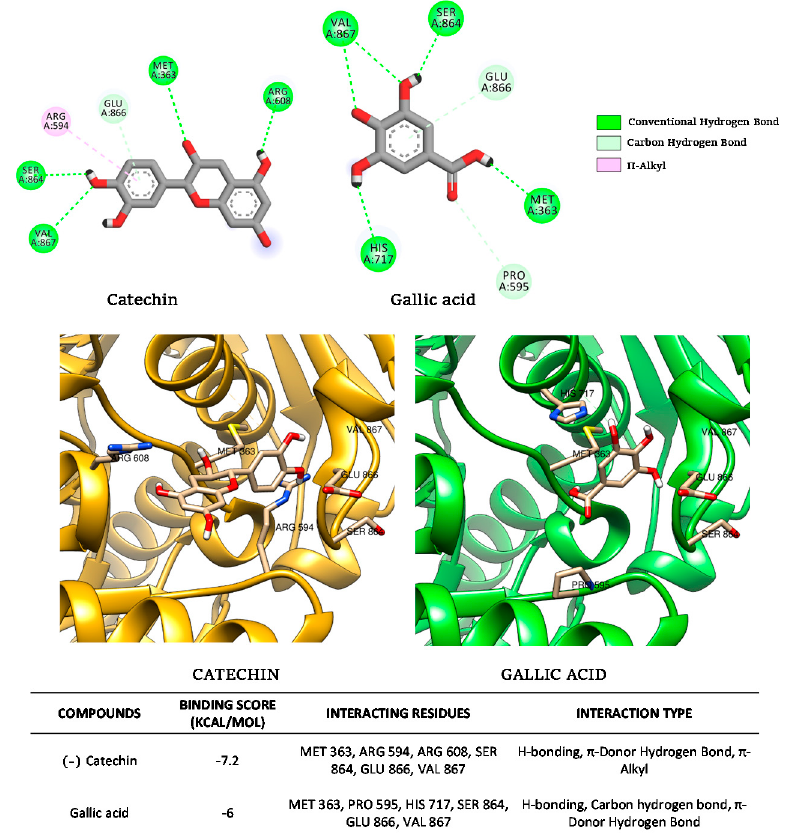
Figure 8. Molecular docking simulations of binding of ( − )-catechin and gallic acid to human intestinal α -glucosidase.